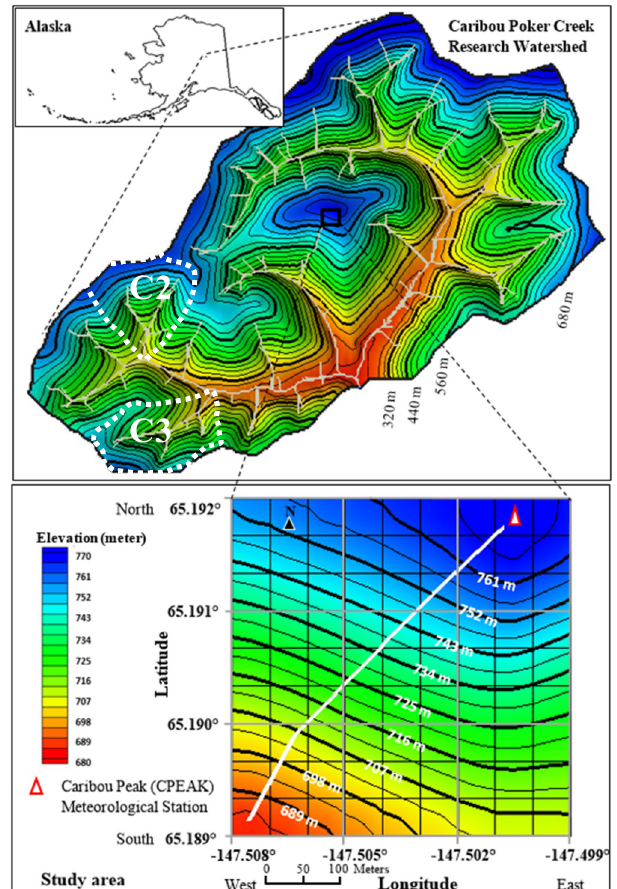
Figure 1. The test case, study area, location encompassing watershed and elevations, and model domain and grid.